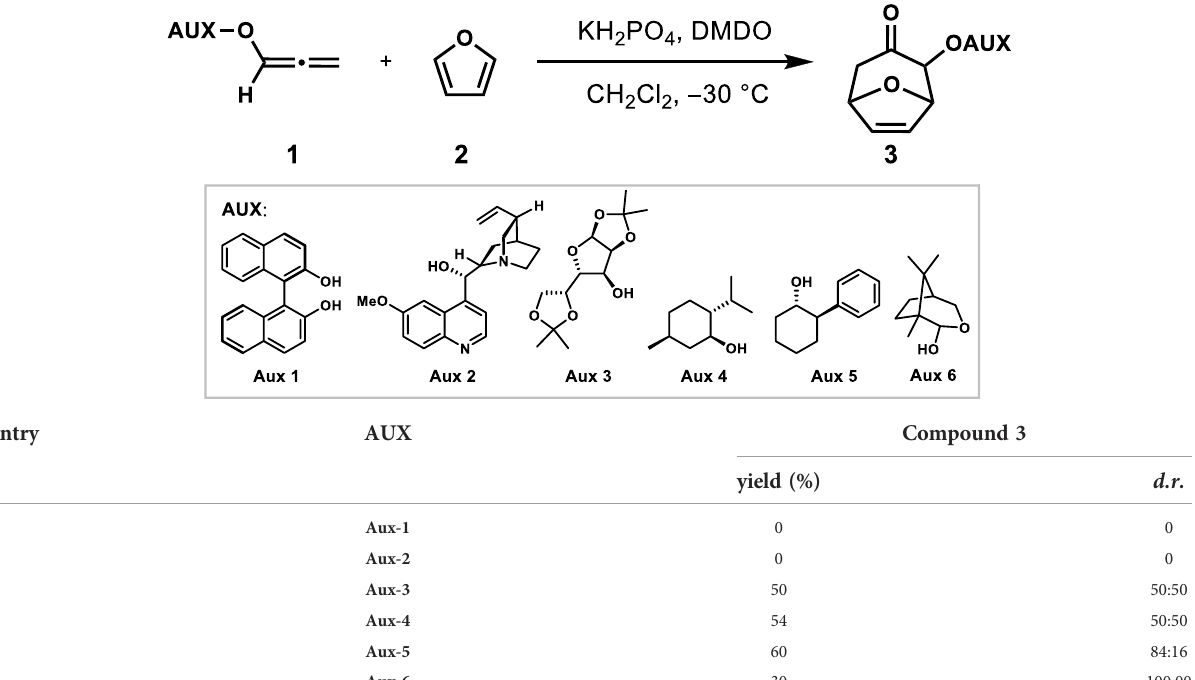
TABLE 1 Screening for chiral auxiliary.